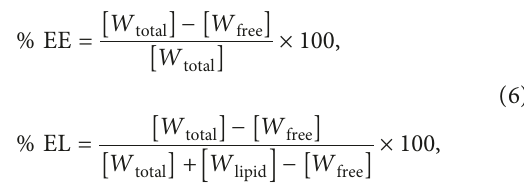
Table 3: Percentage of yields and physical characteristic of green robusta coffee beans.